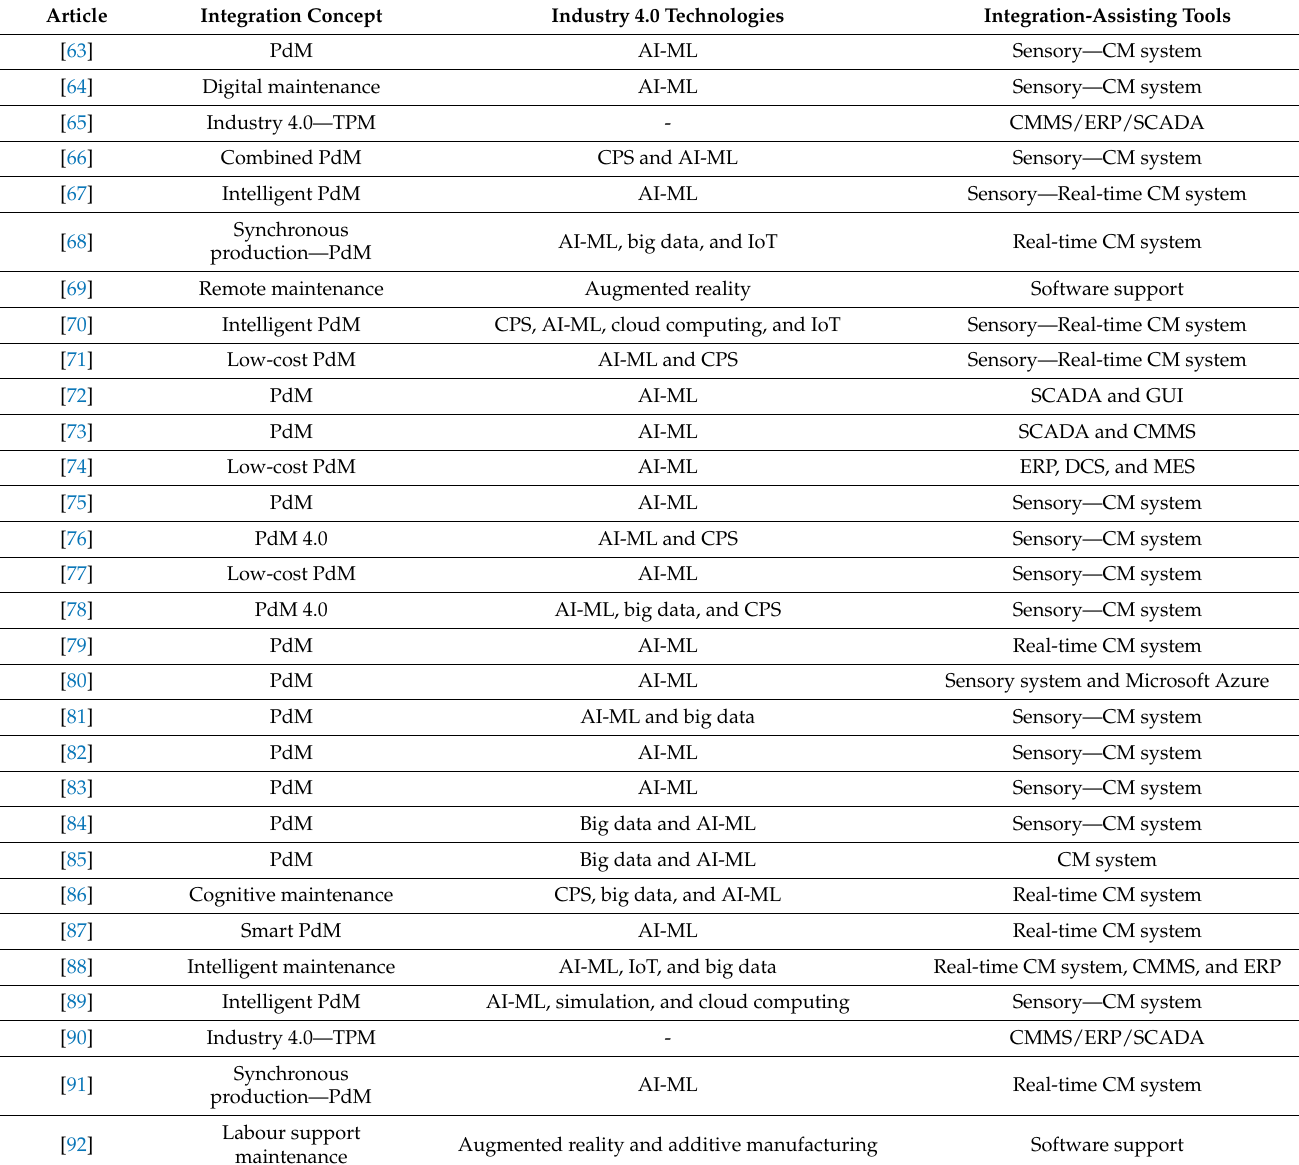
Table A1. Classification results for “integration concept” categories. Source: Authors’